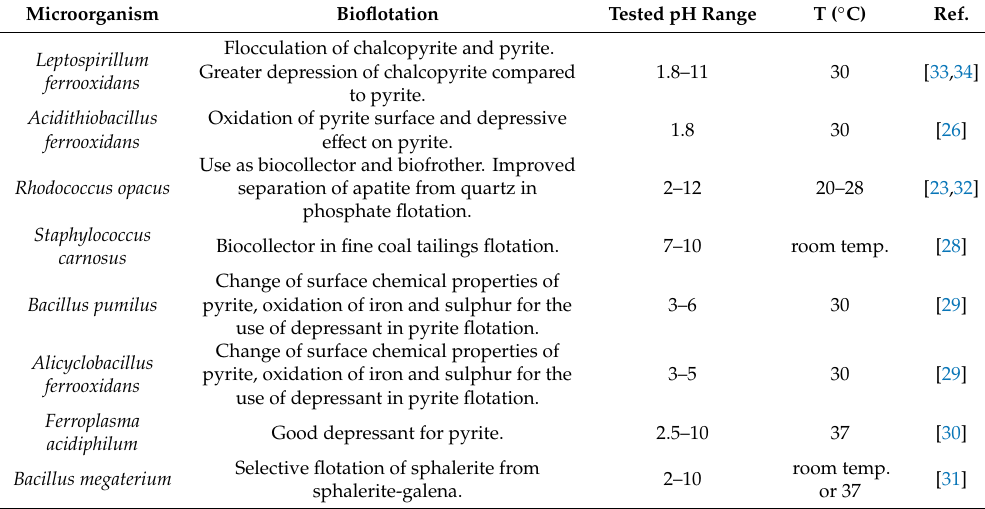
Table 1. A summary of bioflotation tests with pure microbial